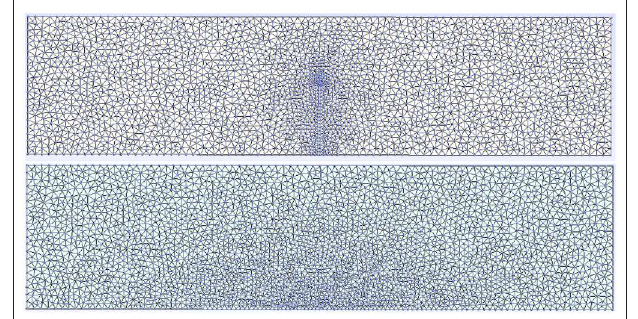
FIGURE 3 | Meshing used when 1 crack and the central bottom boundary are exposed to free water. The mesh is finer where the Dirichlet conditions were imposed according to the physical situation described in Figure 2 .